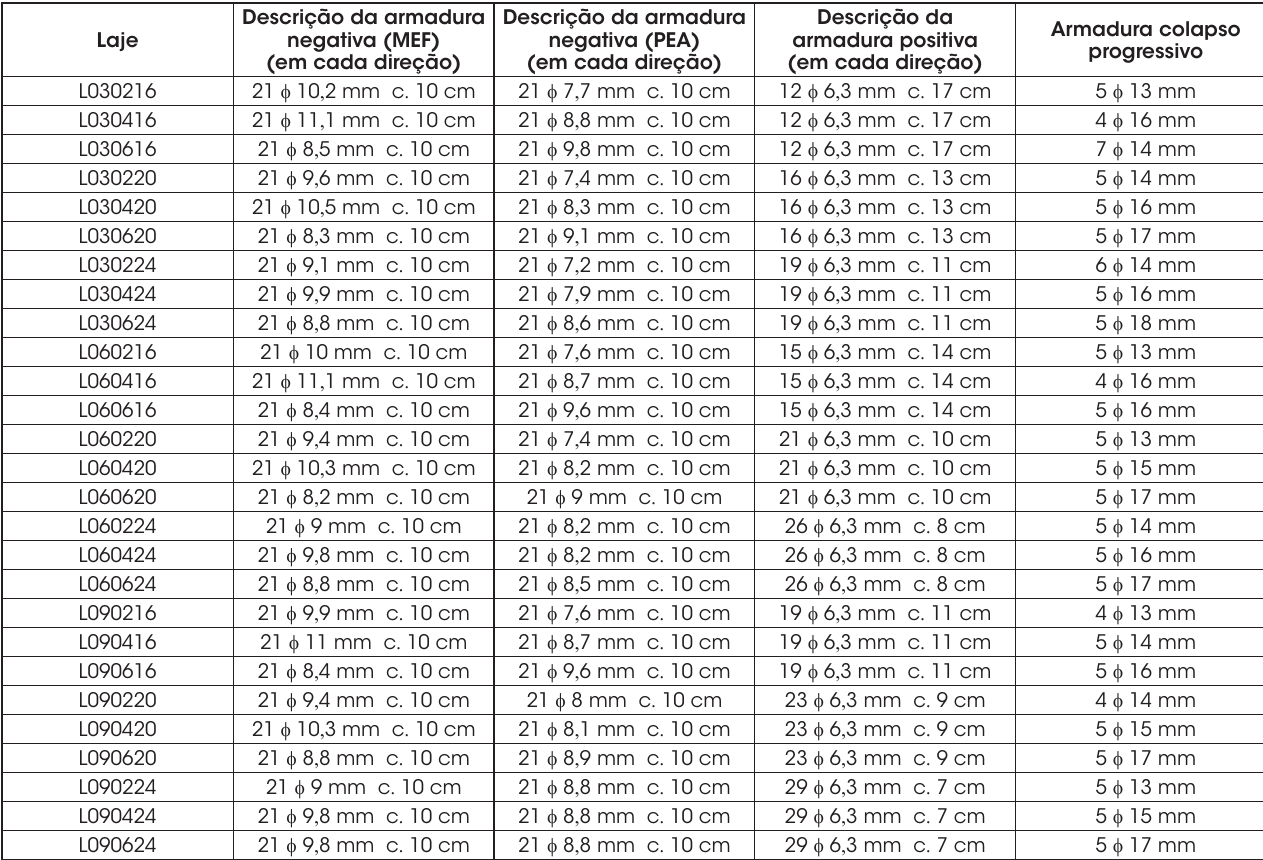
Para o comportamento do aço da armadura foi adotado um mo - delo elastoplástico representados pelo modelo interno do ANSYS, denominado BISO ( Bilinear Isotropic Hardening ).